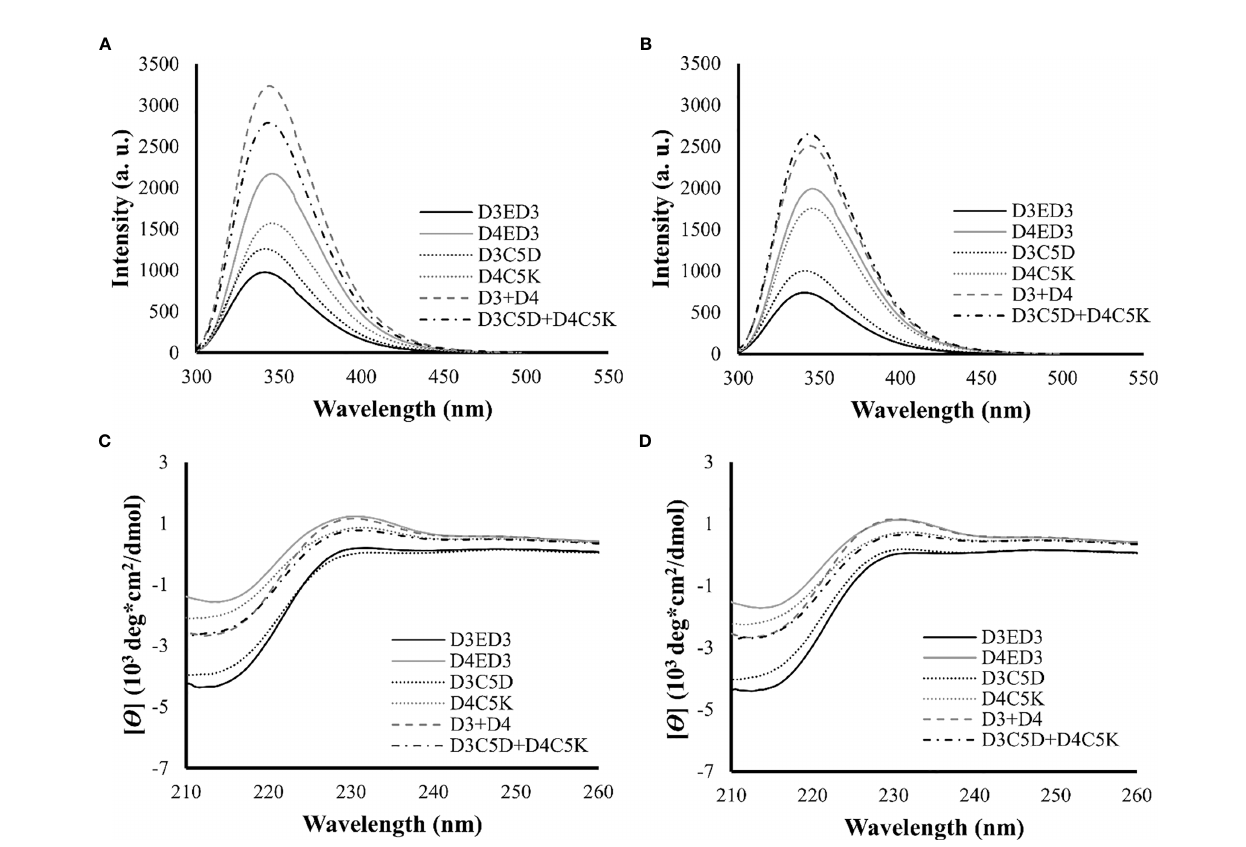
FIGURE 4 | Structural characterization of SCP-tag induced sub-visible aggregates of heterotypic ED3s by fl uorescence and CD measurements. Trp- fl uorescence spectra of D3ED3, D4ED3, D3C5D, D4C5K, D3+D4 and D3C5D+D4C5K at (A) 25°C and (B) 37°C. CD spectra of the tagged and untagged variants as well as D3+D4 and D3C5D+D4C5K (C) 25°C and (D) 37°C. All protein samples were formulated in PBS, pH 7.4, at a fi nal concentration of 0.3 mg/mL. Three accumulations were taken for each measurement. Line symbols are explained within the